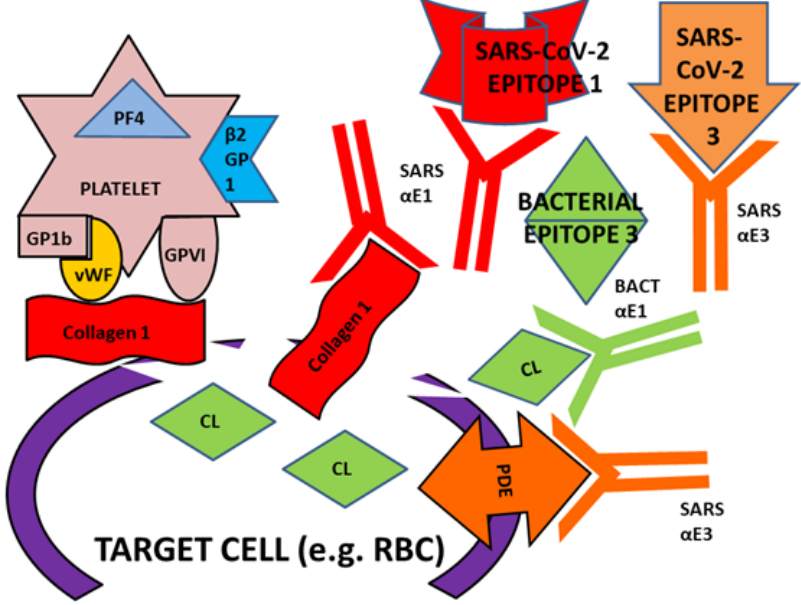
Figure 19. Initiation of platelet activation involves exposure of collagen, which may be achieved by a direct attack on collagen itself, or on other cellular proteins such as phosphodiesterases (PDE), cardi- olipin (CL), or a CL-PDE complex (not shown). Collagen exposure results in von Willebrand Factor (vWF) binding to platelet glycoprotein 1b in concert wit platelet glycoprotein VI, which activates platelets to begin the blood coagulation process. See Figure 16 for the rest of the abbreviations.